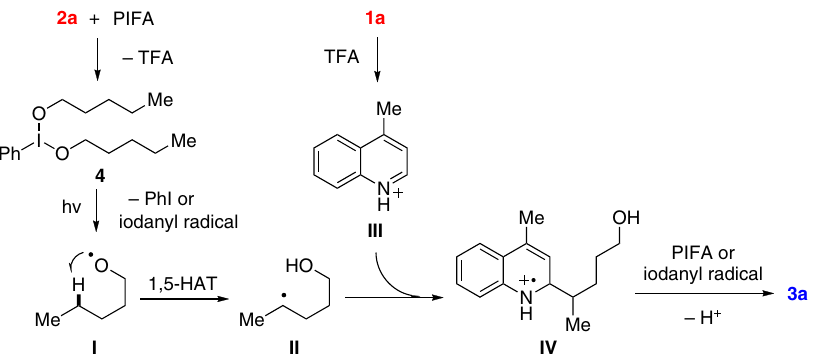
Fig. 4 Plausible reaction mechanism. The proposed pathways for the generation of alkoxy radical from alcohol and the subsequent Minisci-type